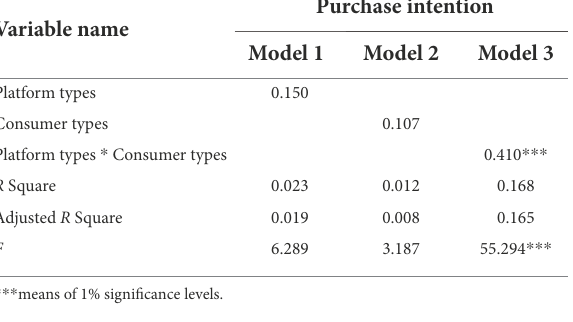
TABLE 2 Results of regression